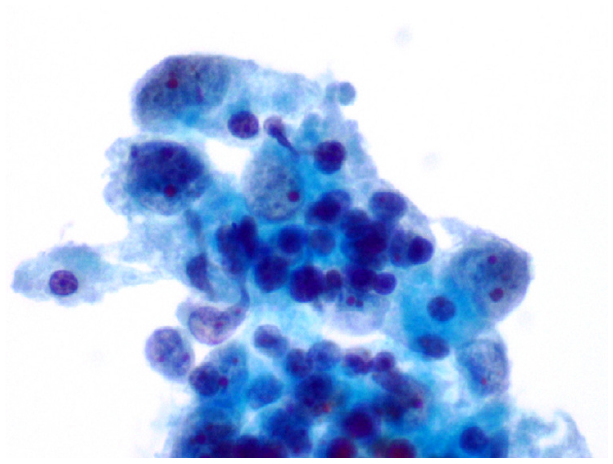
Figure 1 (Papanicolaou stain, × 200): Type AB thymoma. FNA smear shows elongate neoplastic epithelial cells with oval or spindle pale nuclei and inconspicuous nucleoli.